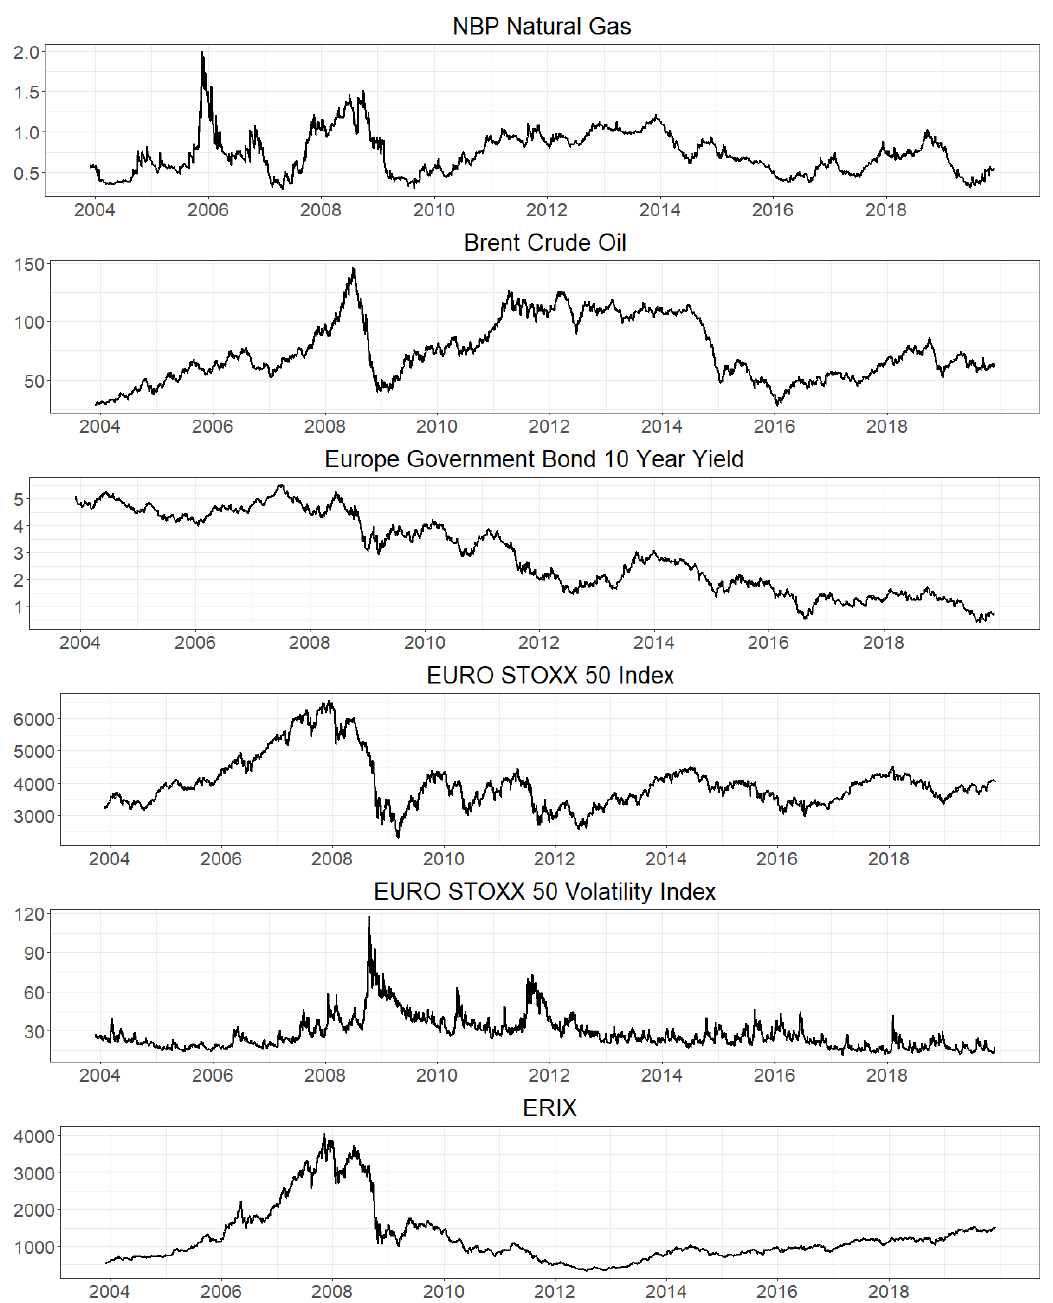
Figure 2. Time-variations of Europe price series. Note: NBP natural gas and Brent crude oil are measured in USD (US Dollar)/therm and USD/barrel, respectively. Note: NBP Natural Gas indicates UK National Balancing Point Natural Gas Futures. Brent Crude Oil indicates ICE Brent Crude Oil Futures. ERIX indicates European Renewable Energy Index.